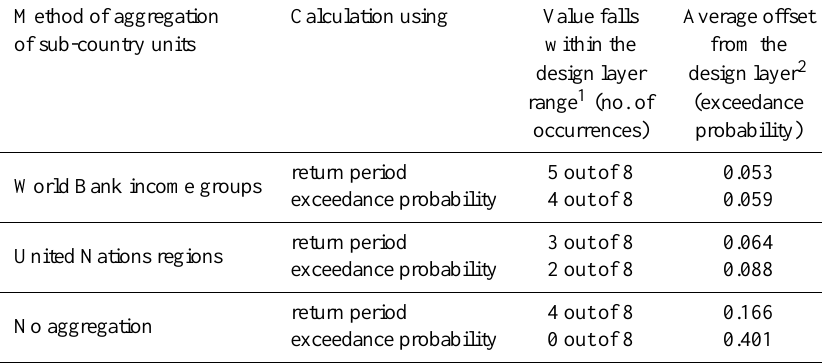
Table 4. Summary of the sensitivity analysis for the model layer, and comparison to the design layer. The criteria for the comparison are the number of occurrences in which the model layer value falls within the range of design layer values, and the average offset between the model layer and the design layer